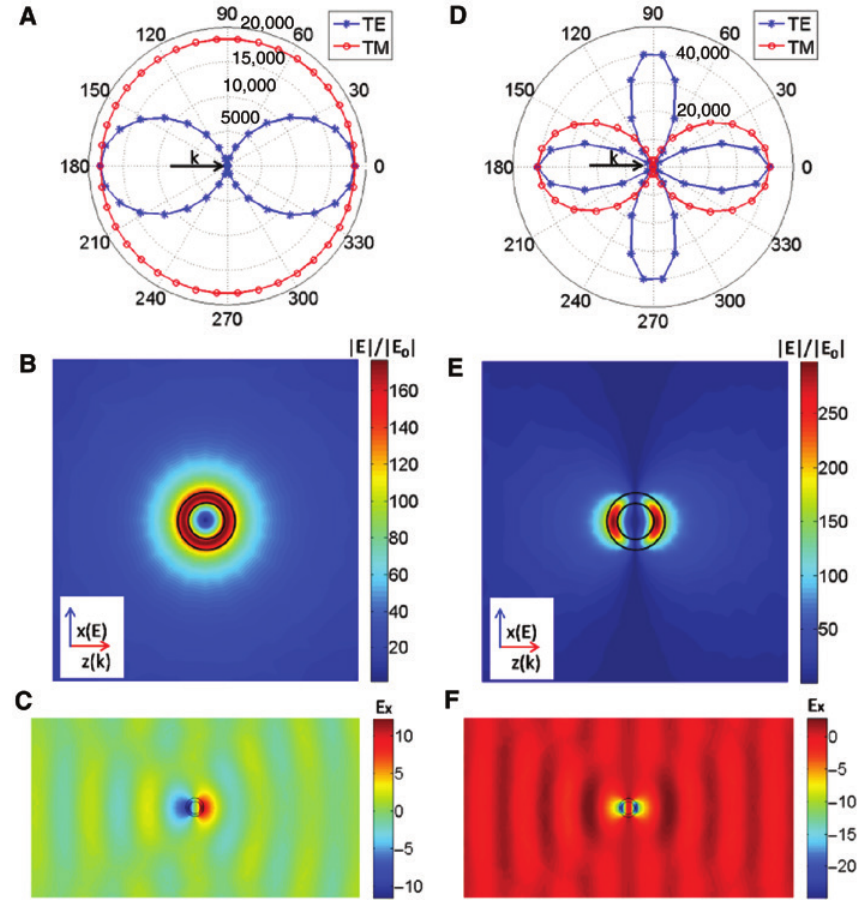
Figure 6: The corresponding far-field scattering patterns at maximum point D (A) and maximum point E (D) consist of both scattering TE (blue line) and TM (red line) components. The corresponding electric field distributions around the nanoparticle are shown as the elec- tric field enhancement factor distributions | E |/| E | at maximum point D (E) in (B) [(E)] and x -component of electric field distributions Ex at 0 maximum point D (E) in (C)